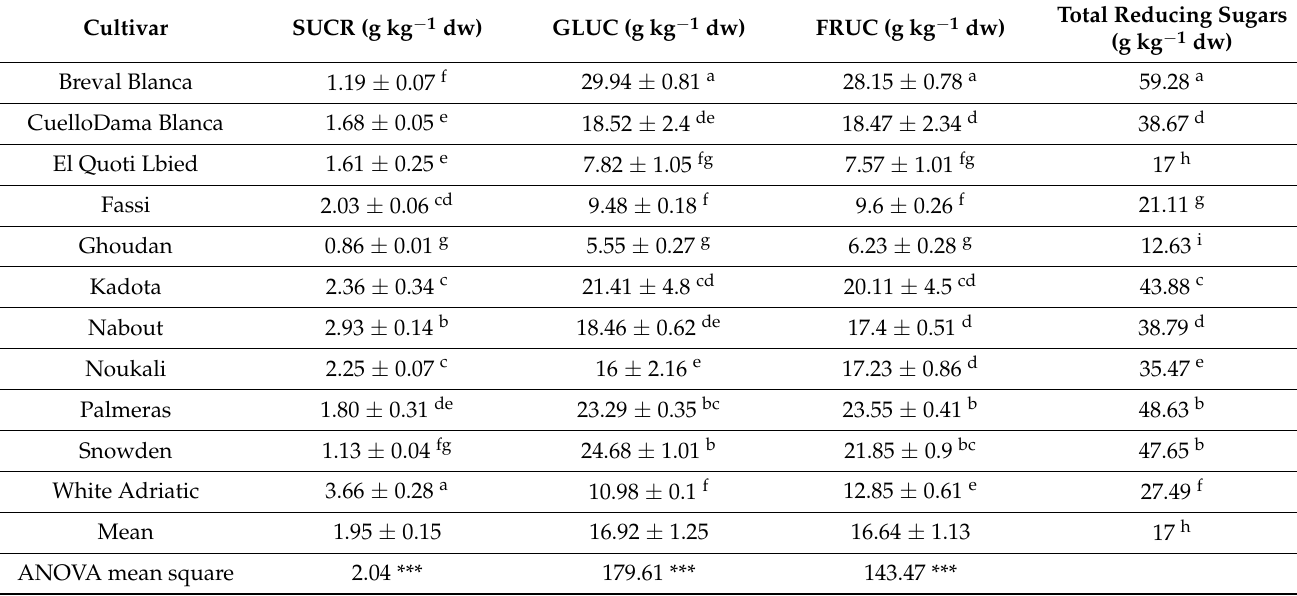
Table 4. Content levels of individual sugars in the whole fruit for 11 fig